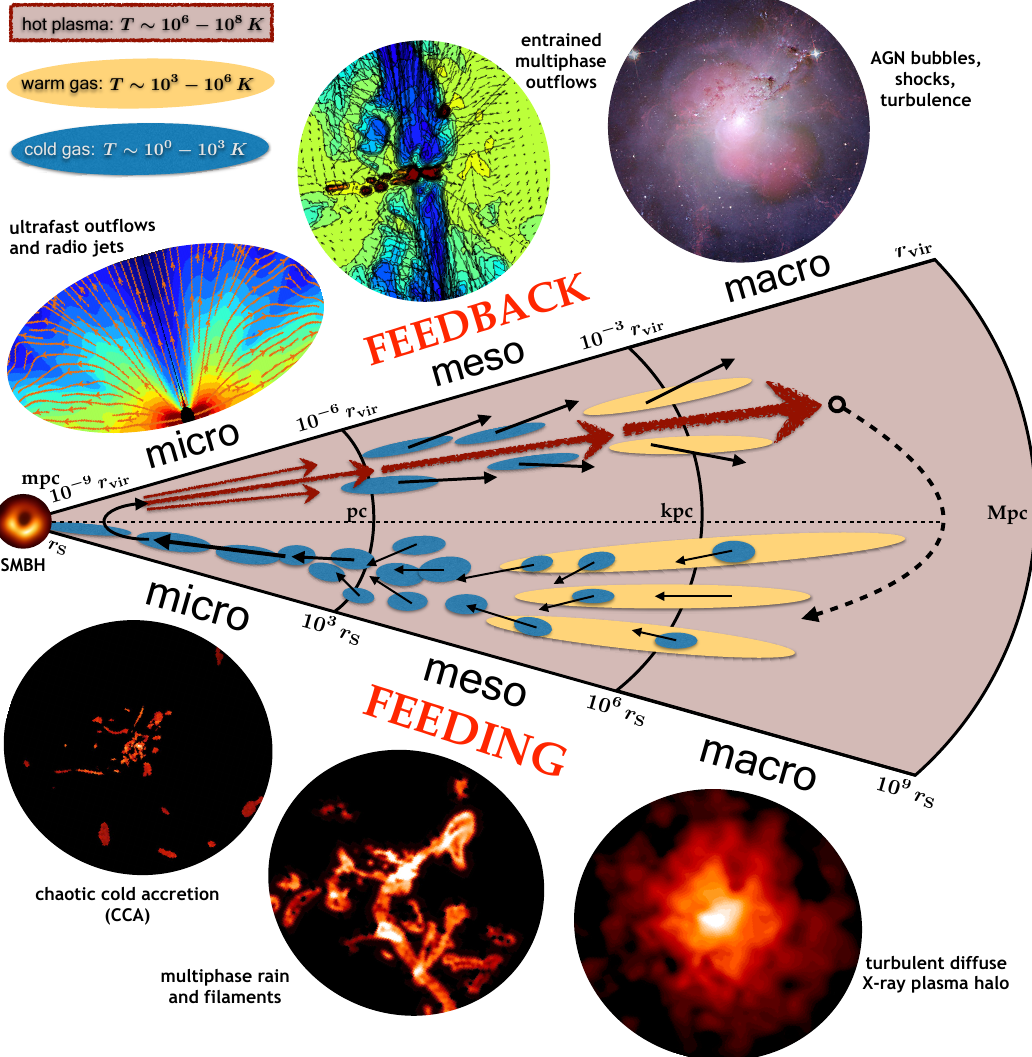
Figure 9. A schematic representation of the self-regulation loop necessary to fully link feeding and feedback pro- cesses over nine orders of magnitude in space (and time) and over the multiphase/multiband cascade, including X- rays (hot halo/outflows), the IR/optical (warm filaments), and radio/mm (molecular clouds) bands—reproduced from Gaspari et al. [11] (arXiv authors’ version). In particular, the IGrM experiences relatively stronger top-down condensation rain compared with clusters, due to the lower central cooling times. Tightly related to such an enhanced feeding is the higher frequency of the AGN outflow/jet feedback events, which gently self-regulate each galaxy group for several billion years during the cosmic